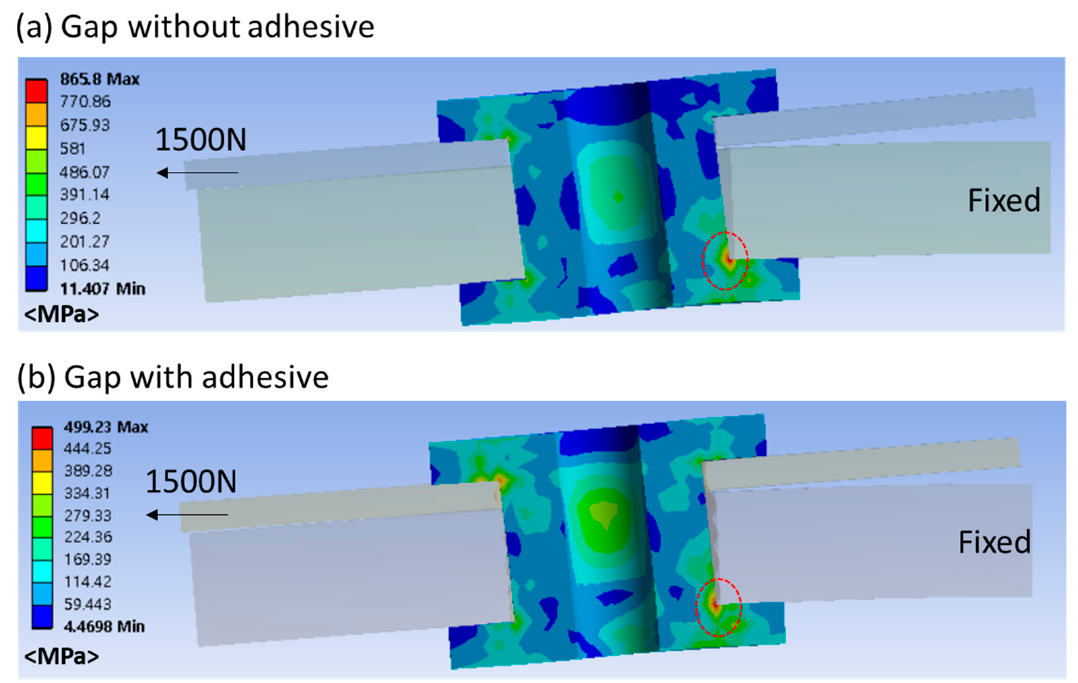
Appl. Sci. 2023 , 13 , x FOR PEER REVIEW 10 of 13